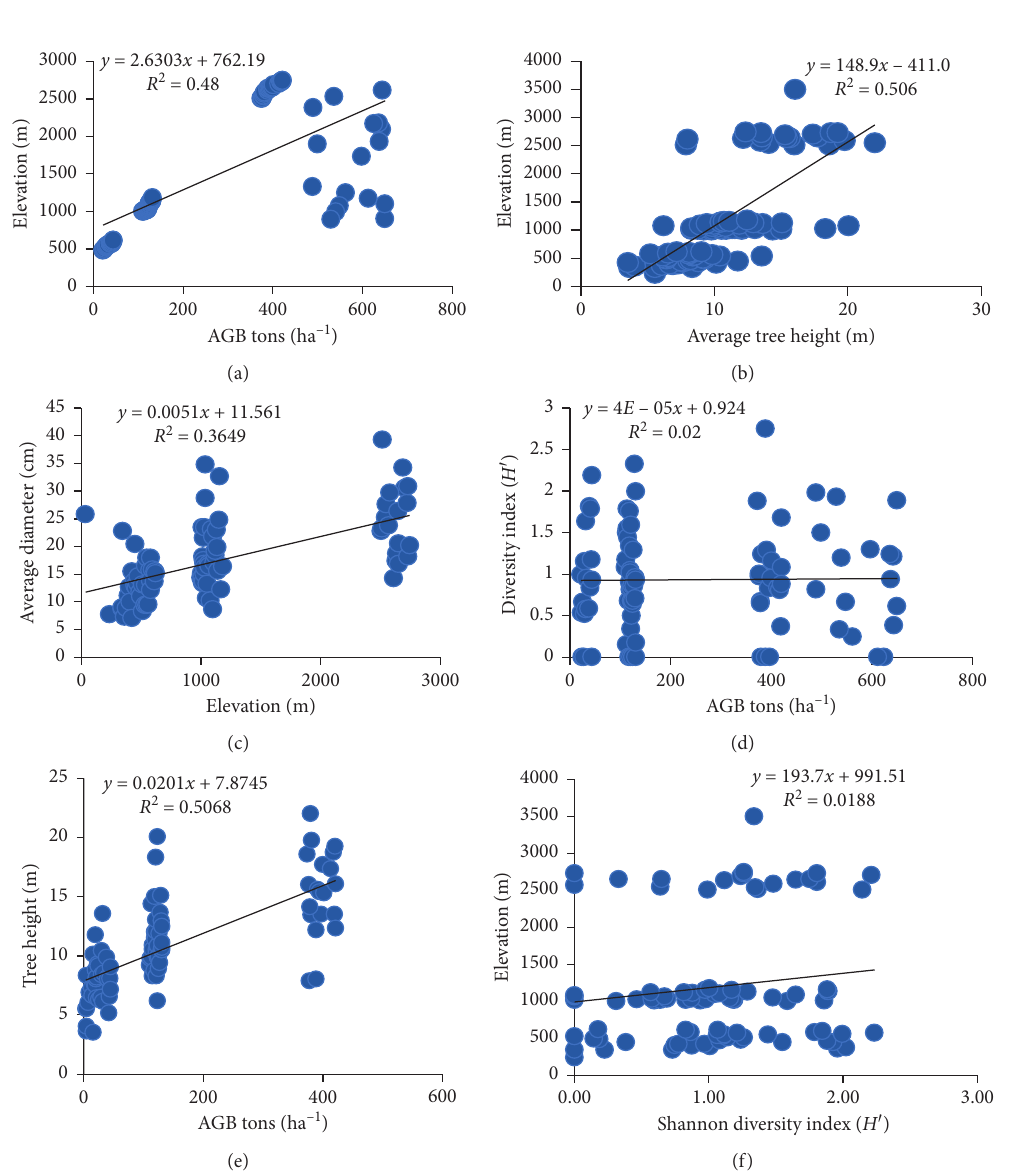
Figure 4: Relationship between AGB, elevation, species diversity, and stand